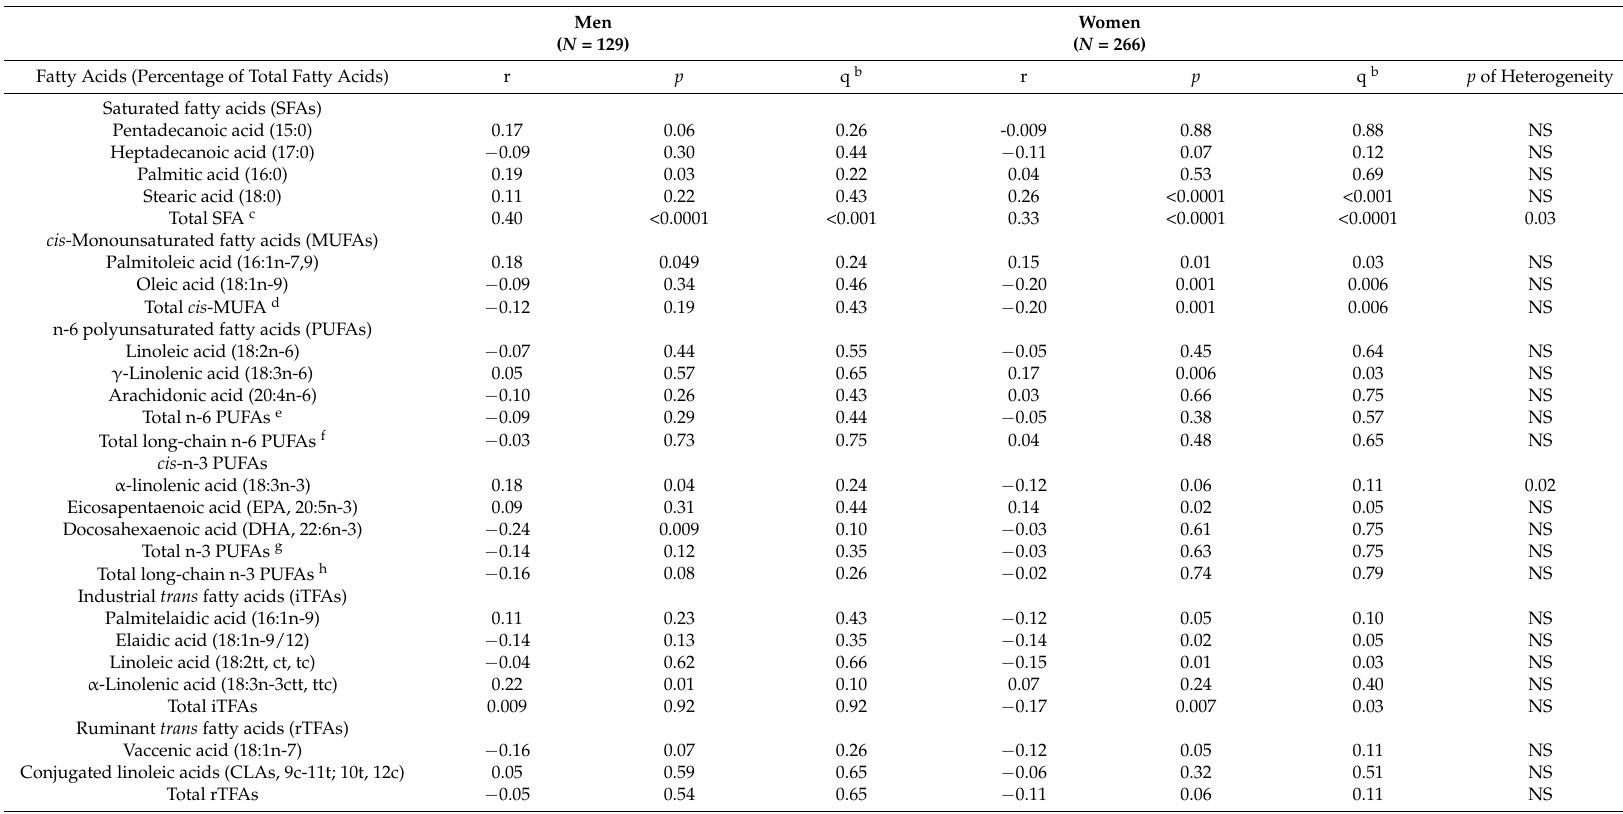
Table 3. Partial Spearman a correlation between serum phospholipid fatty acids and